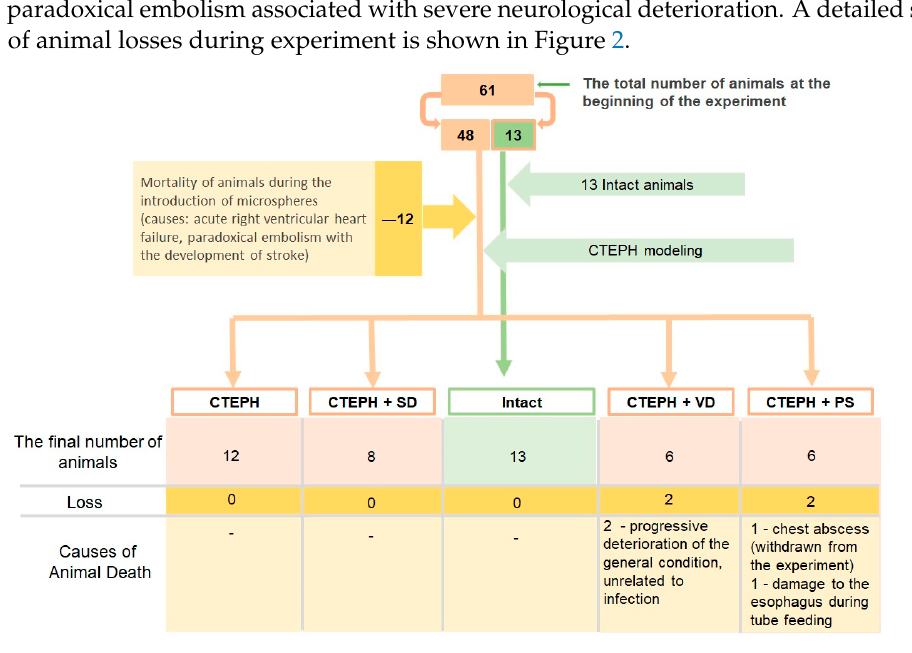
Figure 2. This is a figure. Schemes follow the same formatting. Flow chart of the experimental procedures showing animal mortality and exclusions. CTEPH—chronic thromboembolic pulmonary hypertension, CTEPH + SD—CTEPH + sympathetic denervation, CTEPH + VD—CTEPH + vagus denervation, CTEPH + PS—CTEPH + pyridostigmine. Table 2. Echocardiographic parameters 6 weeks after the last administration of microspheres.